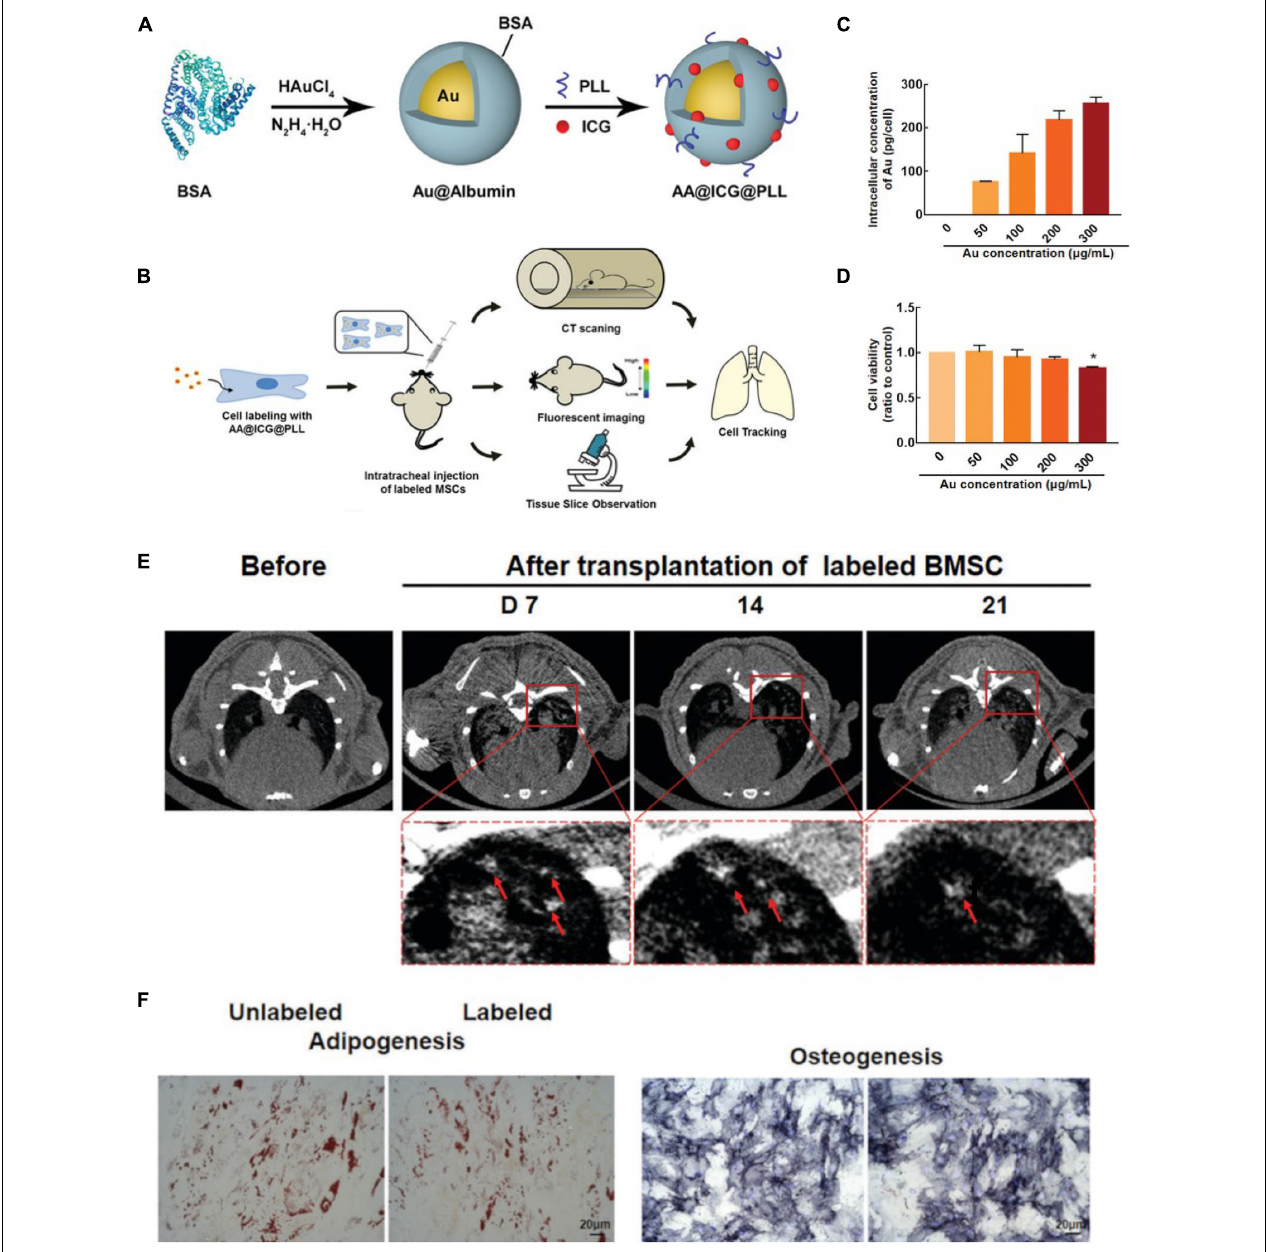
FIGURE 3 | (A) Schematic illustration of the synthesis of AA@ICG@PLL gold (Au)-based nanoparticles (NPs). (B) Experimental design for tracking AA@ICG@PLL-labeled MSCs in a silica-induced PF mouse model. (C) Intracellular Au content measured by ICP-MS. (D) Relative viability of BMSCs labeled with AA@ICG@PLL NPs at various Au concentrations. (E) In vivo computed tomography (CT) images of AA@ICG@PLL-labeled BMSCs at 7, 14, and 21 days after transplantation. (F) Bright-field images of Oil Red O staining and ALP staining of NP-loaded and unloaded BMSCs. Scale bar = 20 mm (adapted by Huang et al., 2020). ∗ p < 0.05 compared with the unlabeled